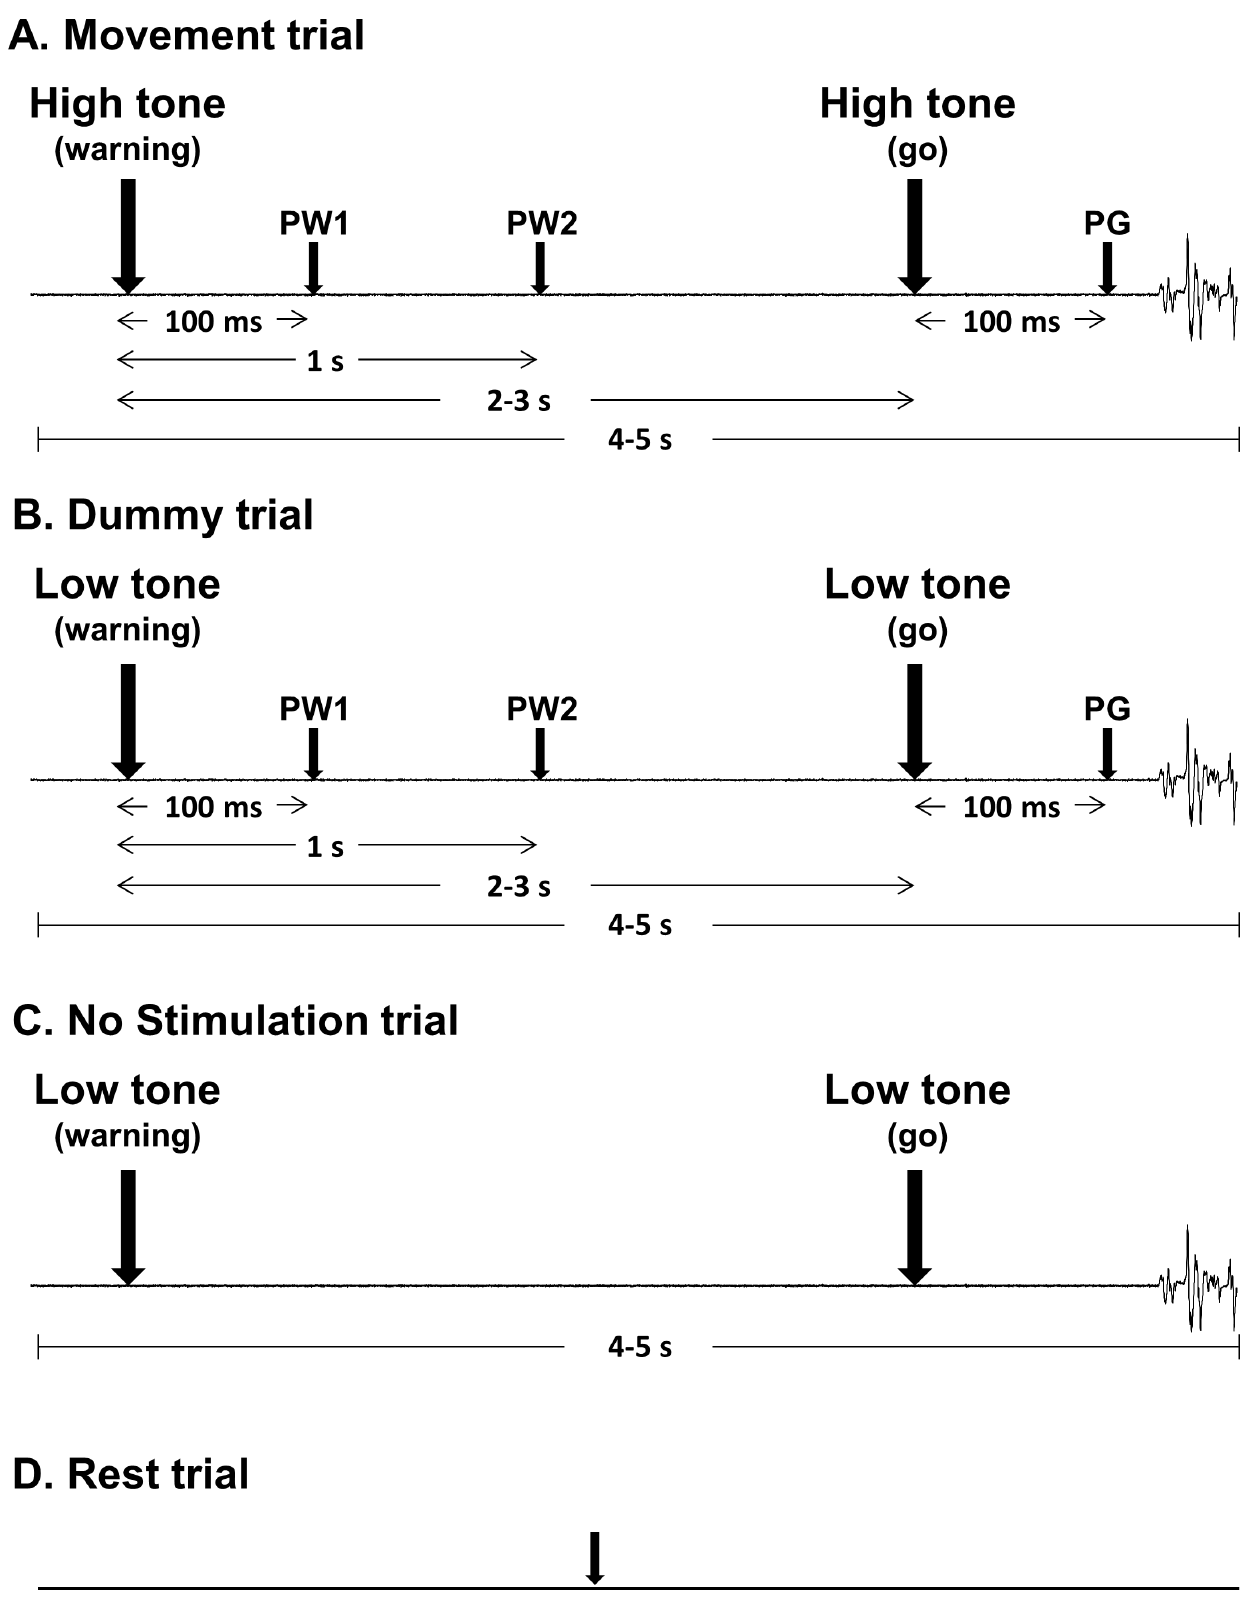
Figure 1. Timeline of the three trial types in a block and the rest trial. The ‘Warning’ and ‘Go’ represent the auditory ‘warning’ and ‘go’ cue, respectively. The small arrows pointing down indicate when SAI was tested. Before the experiment, the researcher defined whether the low and high tone meant move 2 nd or 5 th digit, respectively. The movement trial indicates trials that were used for analysis, while the dummy trial indicates trials